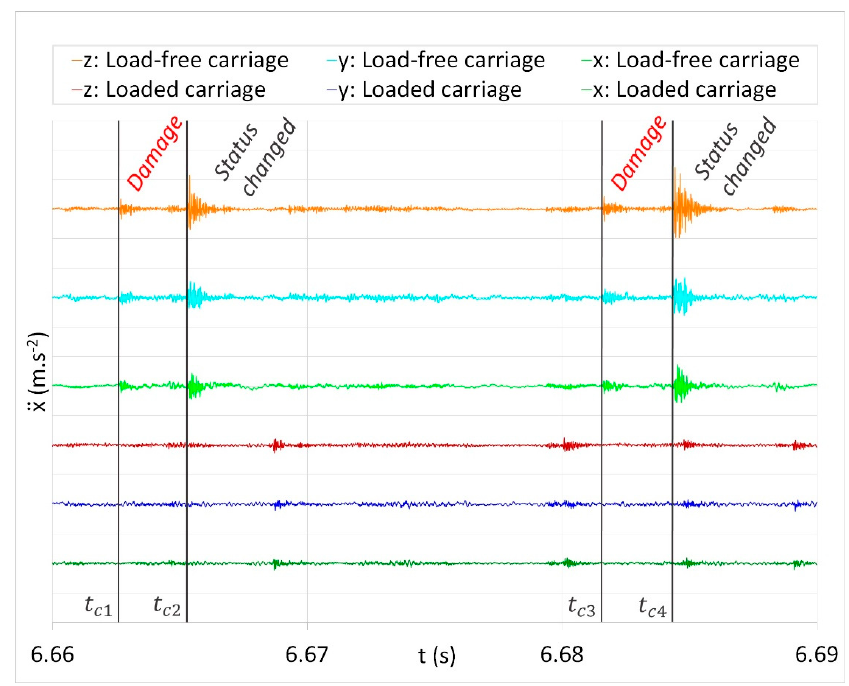
Figure 21. The time graph of acceleration by load-free carriage crossing over the simulated damage: ordinate tick marks: 100 ms − 1 , processed in DeweSoft. Table 6. Time periods and their parameters according to Figure 21. Time Parameters